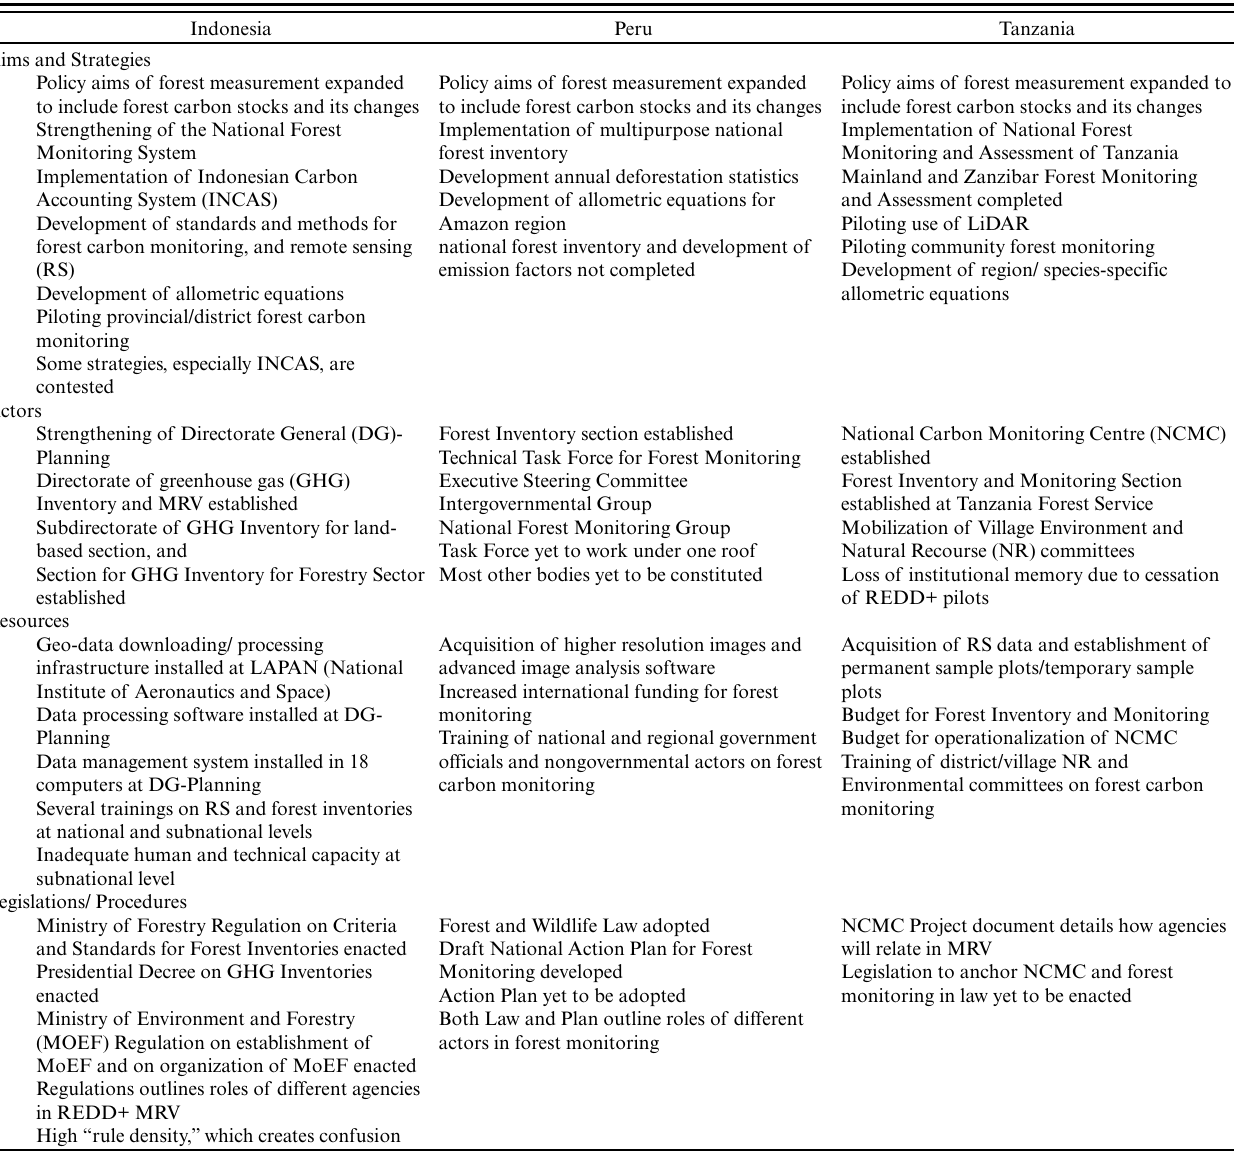
Table 2 . Overview of extent of institutionalization of measurement, reporting, and verification (MRV) in Indonesia, Peru, and